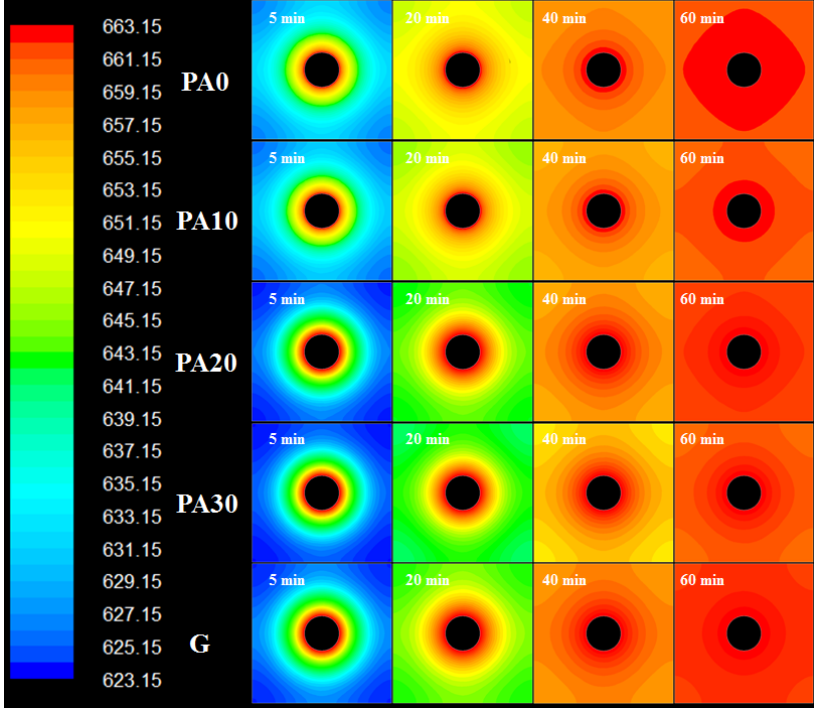
for tested materials, charge phase. tot